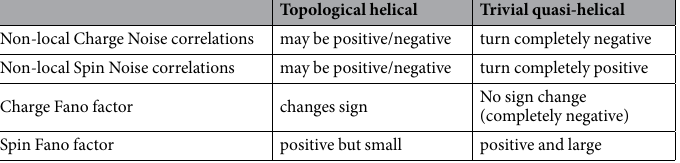
Table 2. Topological helical vs. Trivial quasi-helical edge modes via non-local HBT correlations.